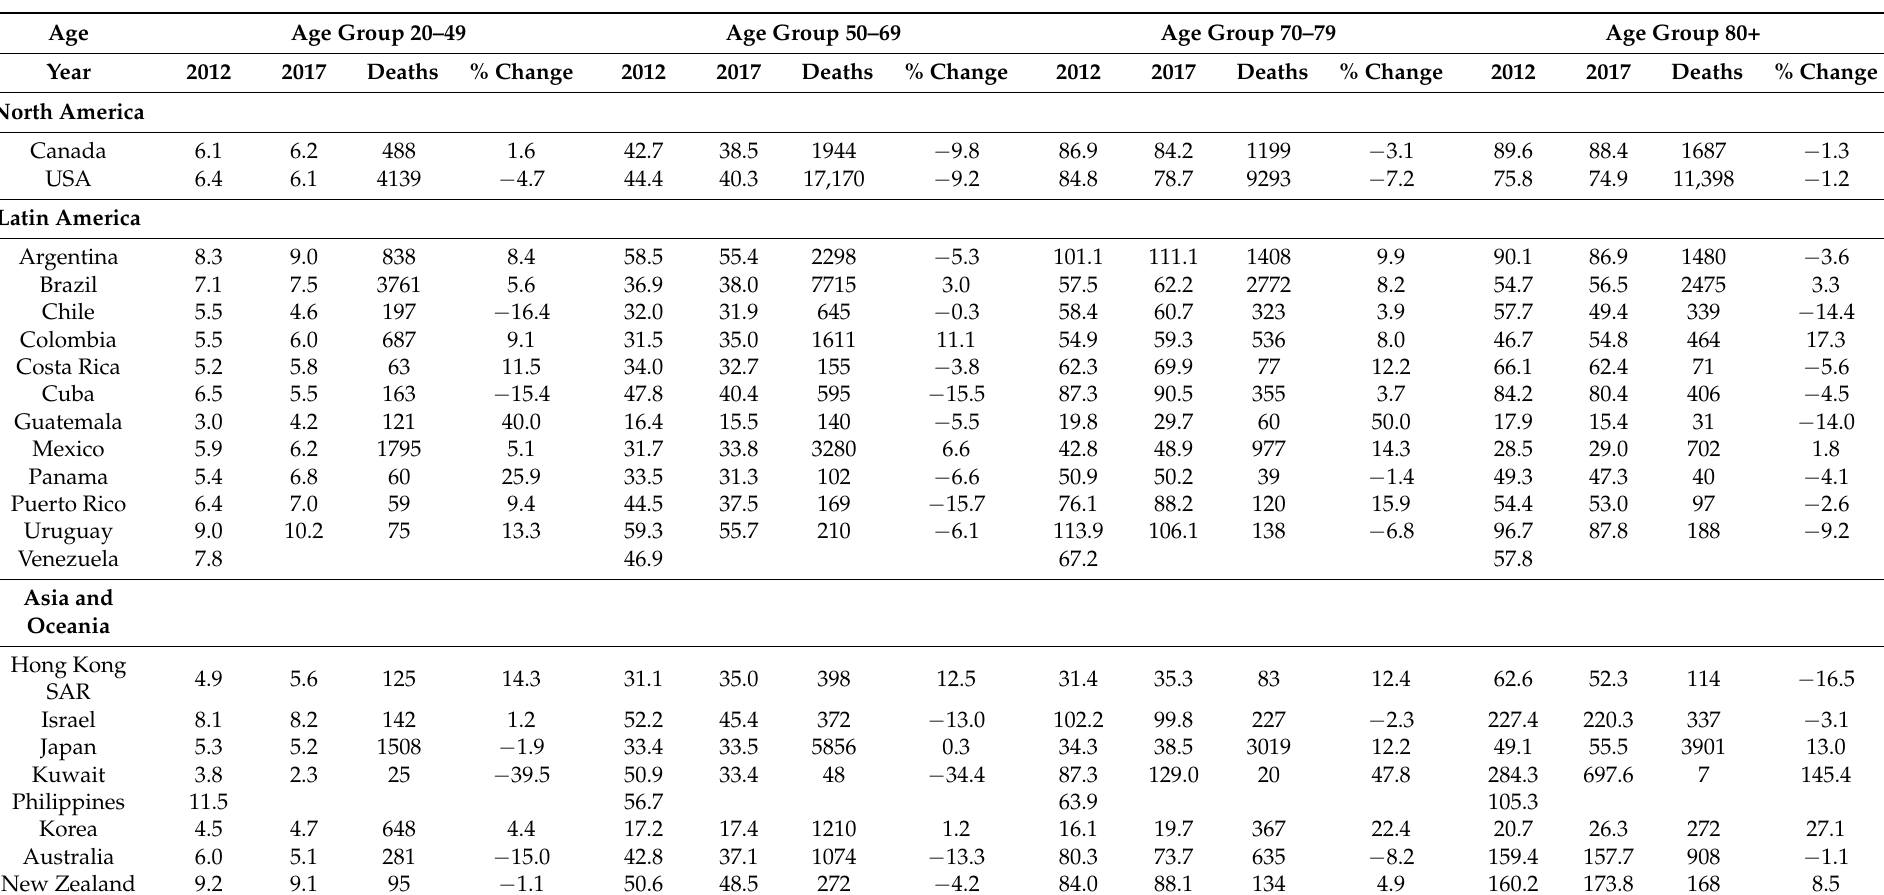
Table 2. Age-standardized (world population) mortality rates per 100,000 women from breast cancer for 4 age groups in selected countries from the Americas and Australasia around 2012 (2010–2014) and in 2017 (or the last available year a ), showing deaths for the latest year and the corresponding percent changes in